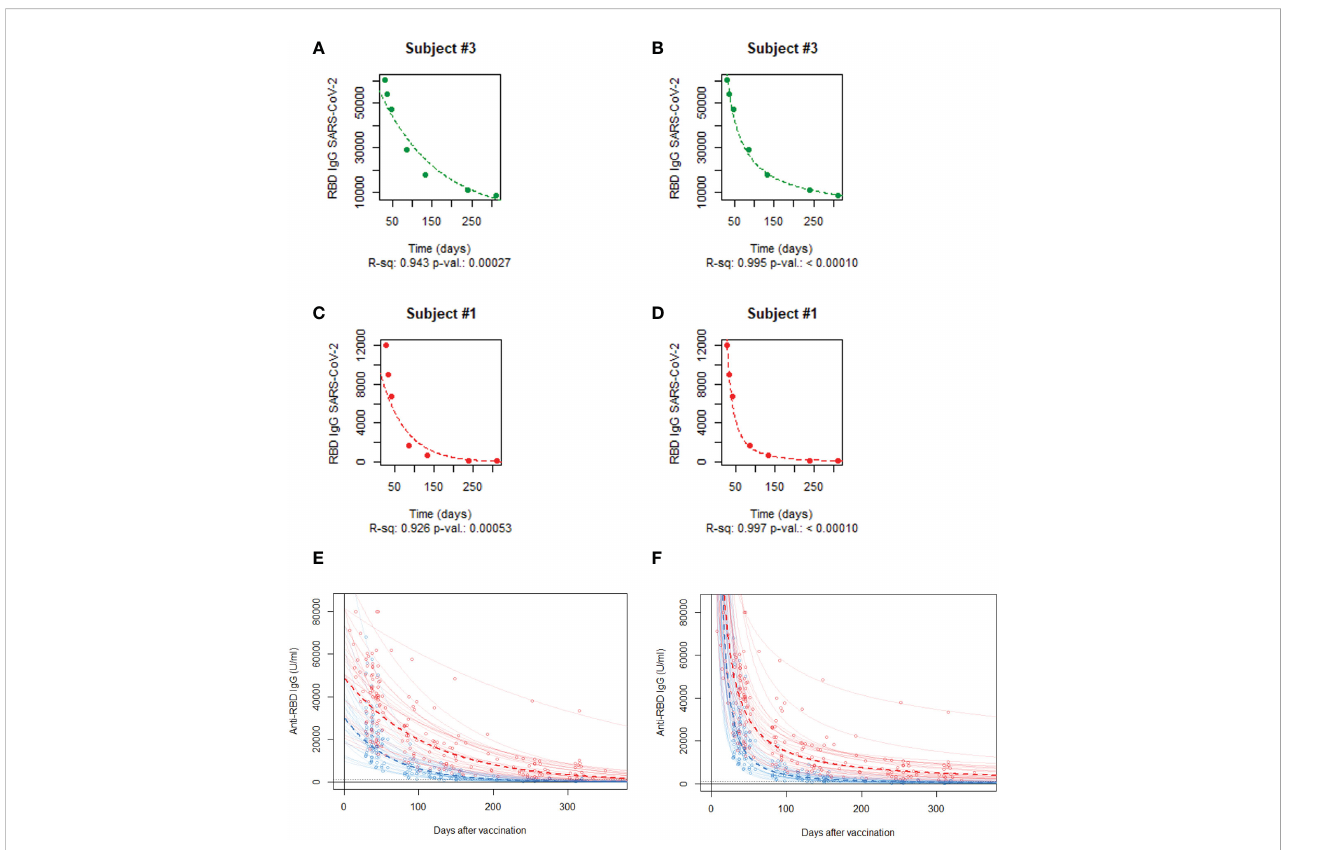
FIGURE 1 Time-course of anti-RBD IgG antibody titers. Representative individual anti-RBD IgG antibody titer curves of a naïve HCW for exponential (A) and power law (B) models. Representative individual anti-RBD IgG antibody titer curves of an experienced HCW for exponential (C) and power law (D) models. Mean curves for exponential (E) and power law (F) models. Individual timepoints for each HCW are represented as open circles (red, eHCWs and blue, nHCWs). Each continuous line represents an ideal antibody waning curve for individual HCWs; dotted lines represent the ideal mean curves. The horizontal dotted line indicates 1.000